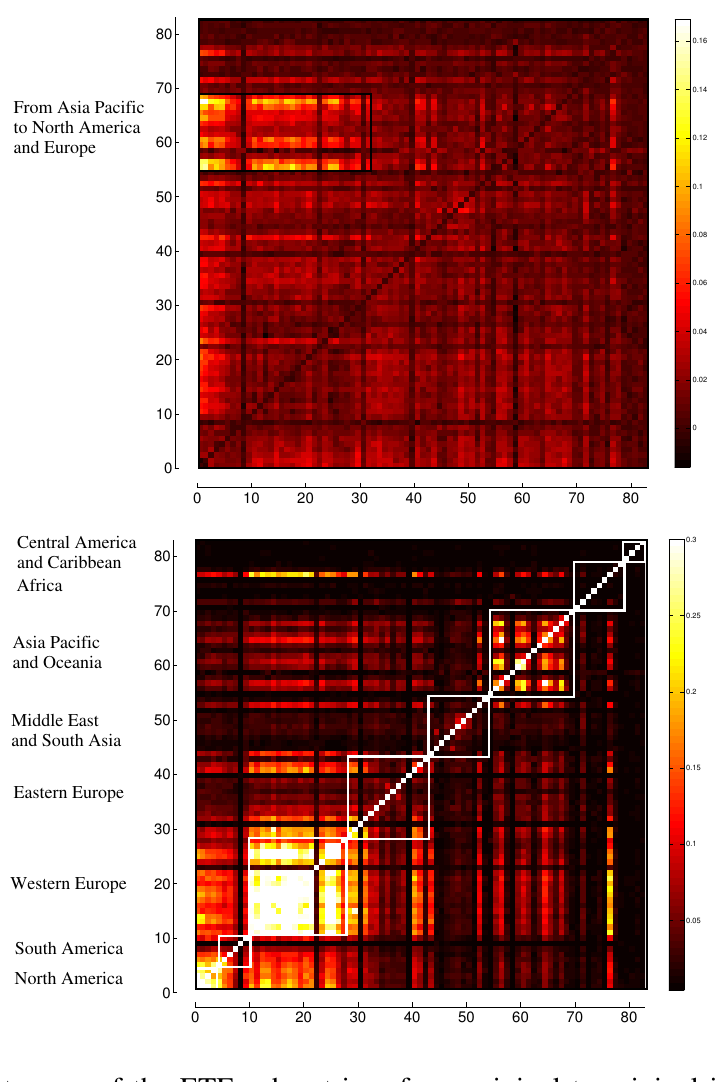
Figure 5. Heat maps of the ETE submatrices from original to original indices and from lagged to original indices, respectively.